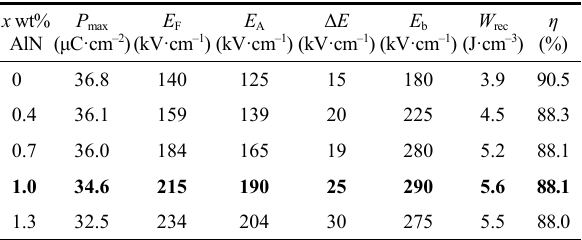
Table 1 Energy storage performance parameters of